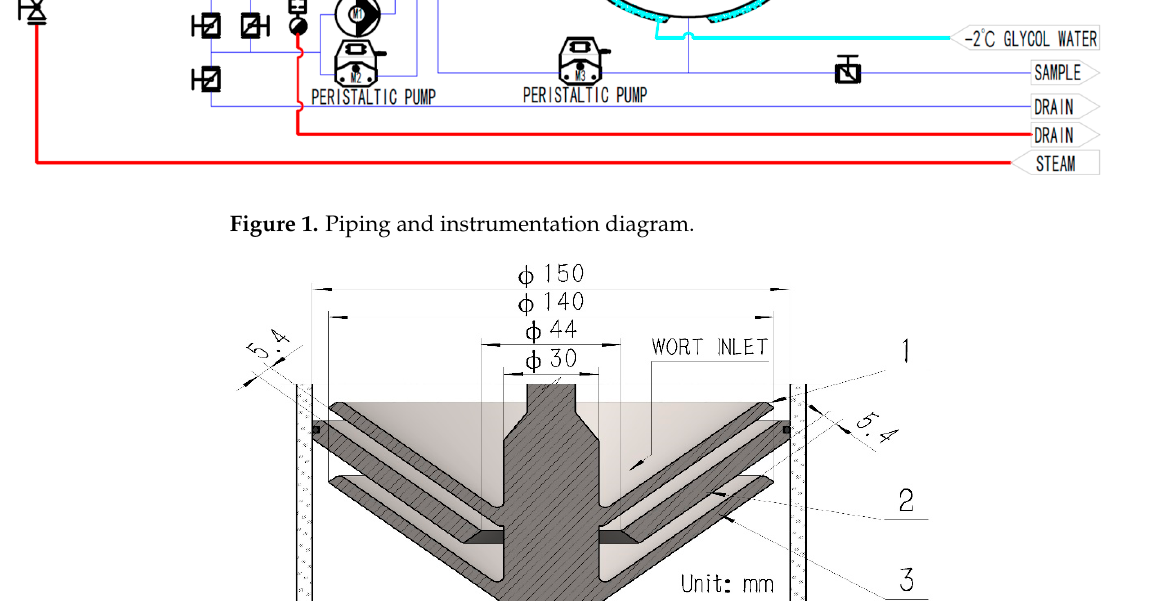
Figure 2. Detailed drawing of the multilayer centrifugal film-forming device. 1-Rotating cone; 2-Fixed cone; 3-Rotating